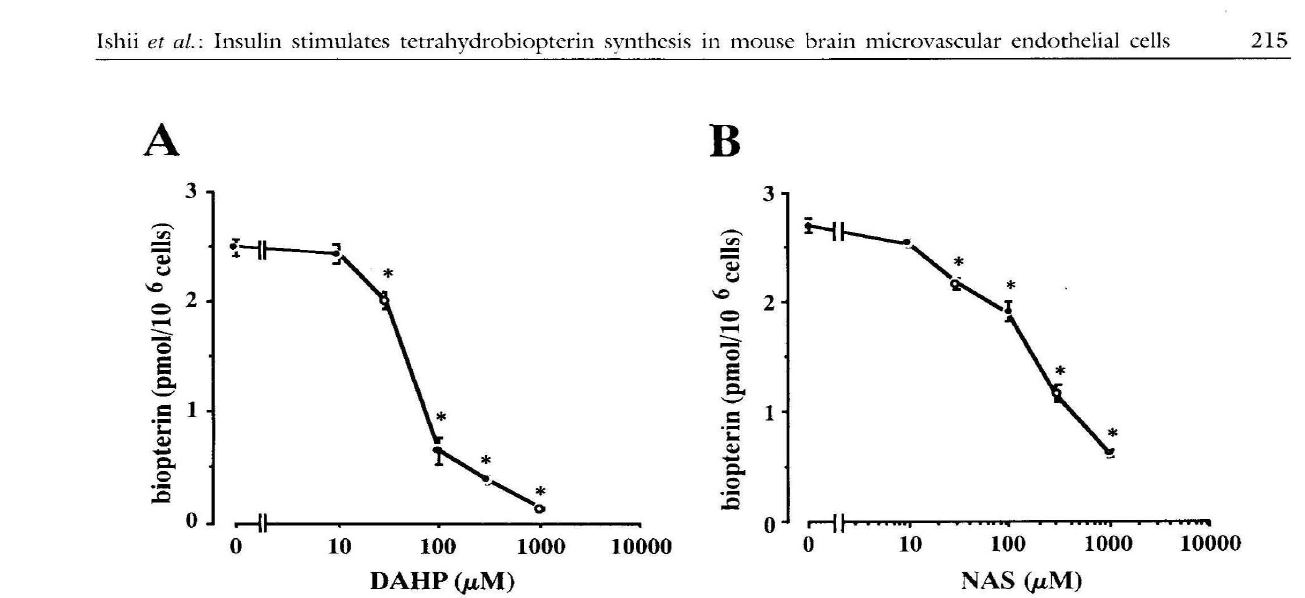
Figure 2. Effects of DAHP and NAS on increase in BH4 content induced by insulin. Cells were incubated with insulin (10 ~g/ml) in the absence or presence of DAHP (l0-1000 ~M: A) or NAS (l0-1000 ~M: B) for 24 h. Results are the means ±S.E.M. of 8-14 assays. *Significant change in comparison to insulin alone group